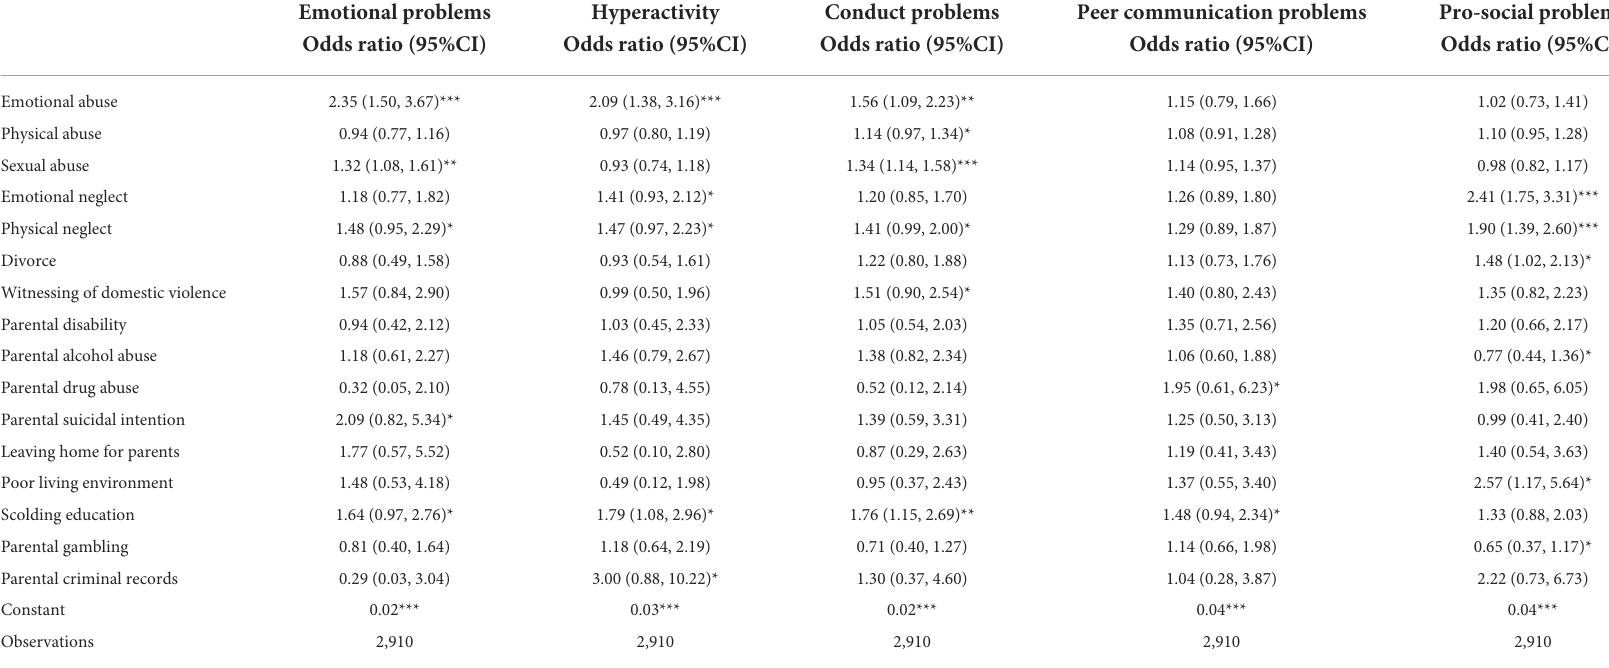
TABLE 3 Logistic regression models estimating associations of specific types of ACEs experienced with behavioral problems from 12 to 14 years